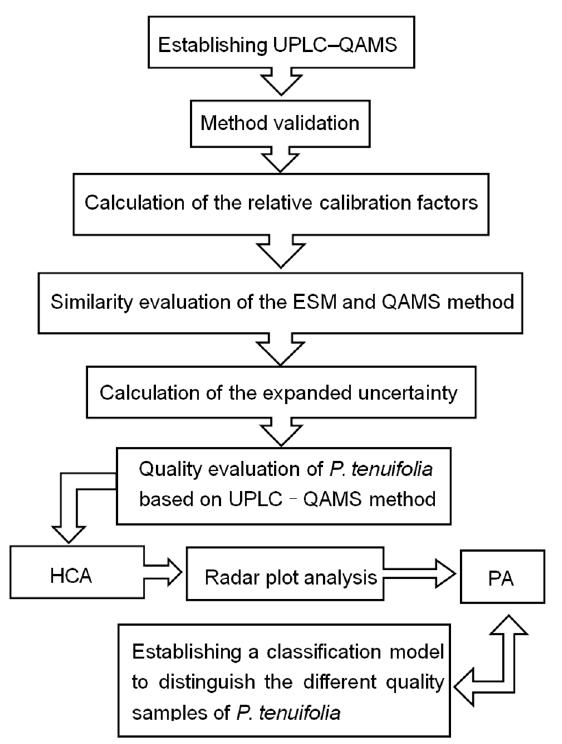
Figure 6. Flow diagram of the experiment.